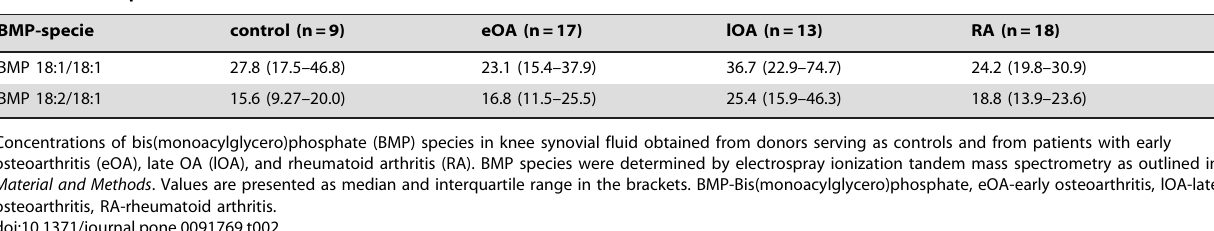
Material and Methods . Values are presented as median and interquartile range in the brackets. BMP-Bis(monoacylglycero)phosphate, eOA-early osteoarthritis, lOA-late osteoarthritis, RA-rheumatoid